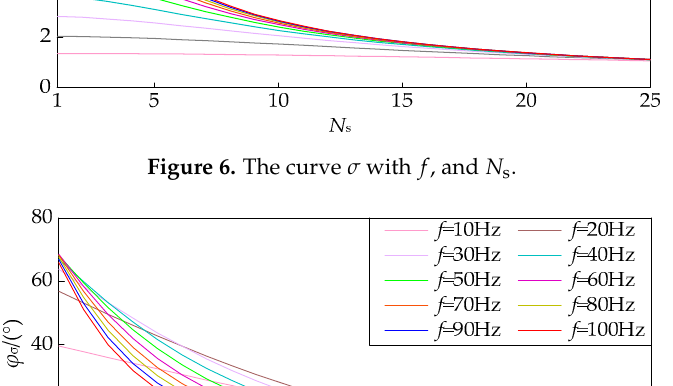
φ with f , and σ φ with f , and σ